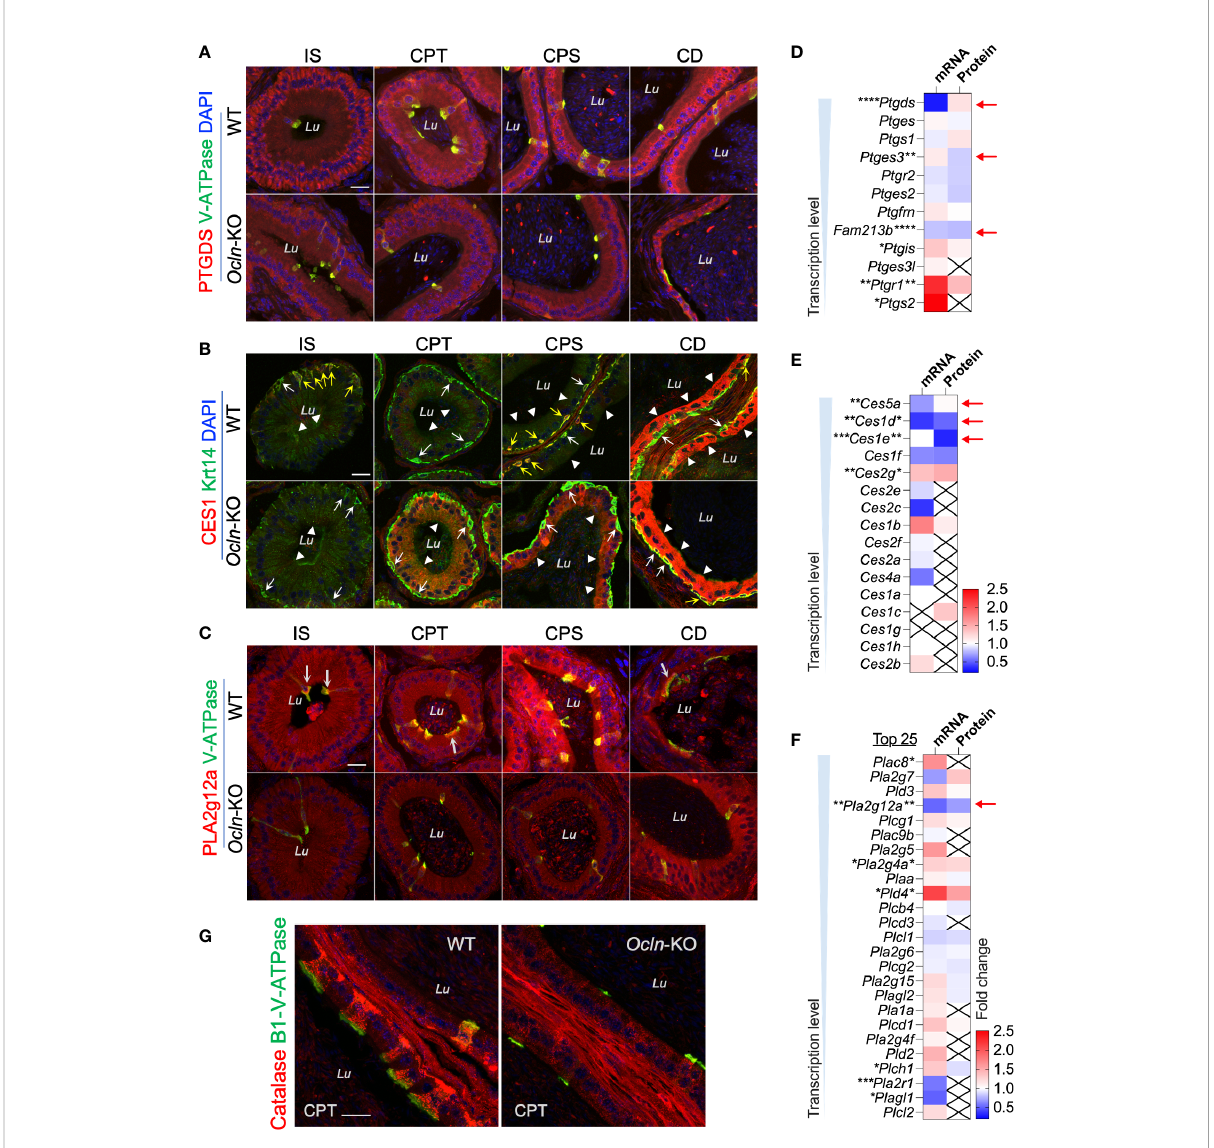
FIGURE 7 Expression levels of genes relating to lipid metabolism in the epididymis of Ocln -KO compared to WT mice. (A) Regional distribution and cellular localization of prostaglandin enzyme PTGDS in WT and Ocln- KO mouse epididymis. (B) Double-immuno fl uorescent labelling using a pan-CES1 antibody (red) with the basal cell marker Krt-14 (green) showing the regional distribution and cellular localization of CES1 in WT and Ocln- KO mouse epididymis. White arrows: basal cells with negligible CES1 labelling. Yellow arrows: basal cells with intense of CES1 immuno fl uorescent labelling. Arrowheads: principal cells. (C) Regional distribution and cellular localization of PLA2g12a in WT and Ocln- KO mouse epididymis. Arrows: enriched PLA2g12a in the apical domain of clear cells labeled in green for B1-V-ATPase. (D-F) Heatmaps of the DEGs relating to arachidonate-associated derivatives converting enzymes (D) and carboxylate esterases (E) , and membrane-associated or secreted phospholipases (F) in the transcriptomes and proteomes of mouse whole epididymis. Arrows indicated the genes signi fi cantly downregulated in the transcriptomes and/or proteomes. (G) Immunolabelling of epididymal cryosection showing enriched catalase in clear cells of WT epididymis and the obviously decreased expression in the clear cells of Ocln- KO epididymis. Lu, lumen; IS, initial segment; CPT, caput; CPS, corpus; CD, cauda epididymidis. Data were analyzed by two-tailed unpair t-test; * P< 0.05 and ** P< 0.01, *** P< 0.001, **** P < 0.0001 (n>3 mice per group). Scale bar 20